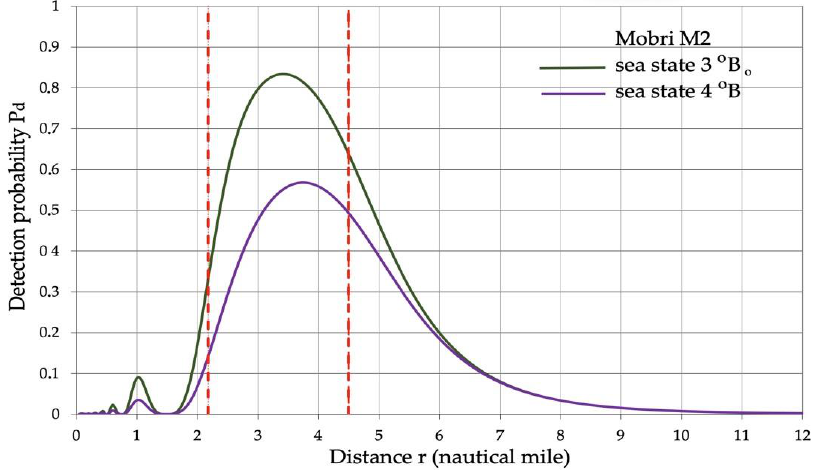
Figure 11. Detection probability of the Mobri M2 reflector during tests under sea states 3 and 4 °B. During the tests, it was observed that the quality of the signal reflected from the quality of the signal reflected from the reflectors positioned at a distance of 4.50 nm.